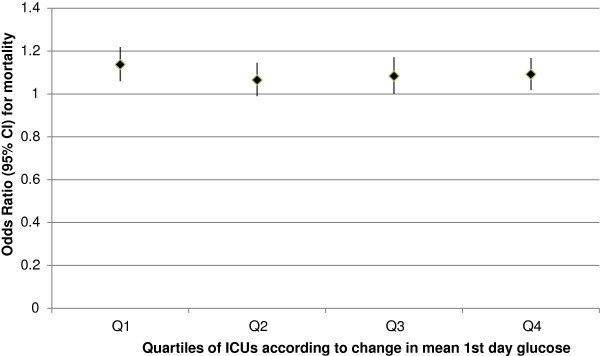
Adjusted mortality in quartiles of ICUs according to change in Glu1. Odds ratios (95% confidence intervals) for mortality in quartiles of ICUs according to changes in mean first day glucose values (Q1 denotes ICUs with the smallest change, Q4 denotes ICUs with the highest increase). P <0.001 for Q1, P ns (>0.01) for Q2 to 4.